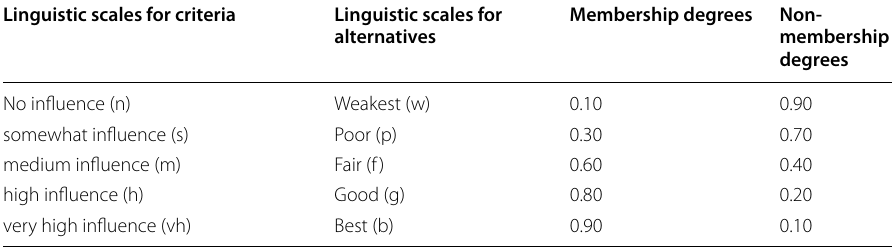
Table 2 Linguistic scales, membership, and non-membership degrees for criteria and alternatives Linguistic scales for